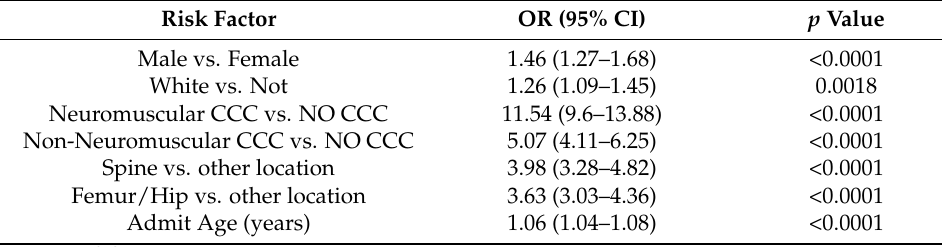
Table 4. Multivariable Logistic Model for Postoperative Urinary Retention. Risk Factor OR (95% CI) p Value Male vs.